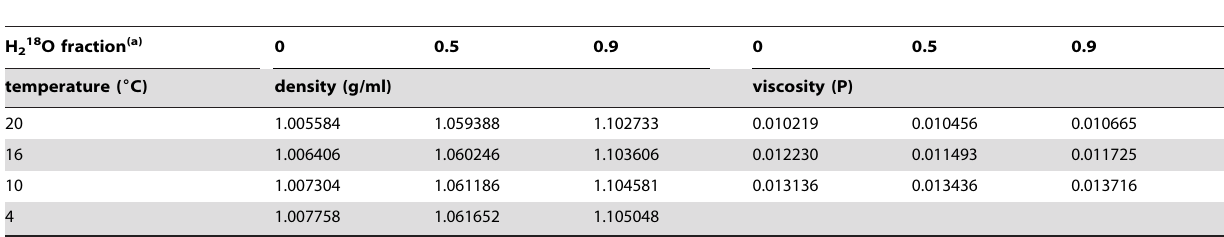
Table 1. Density and viscosity values measured for PBS solutions containing different fractions of H 218